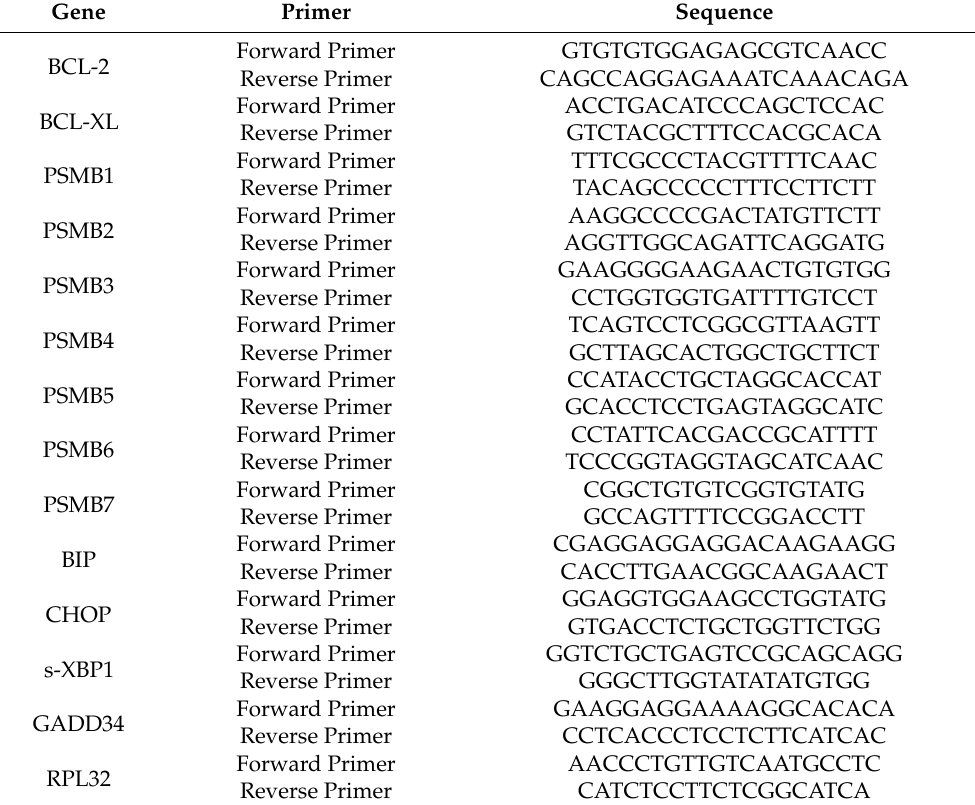
Table 1. List of PCR